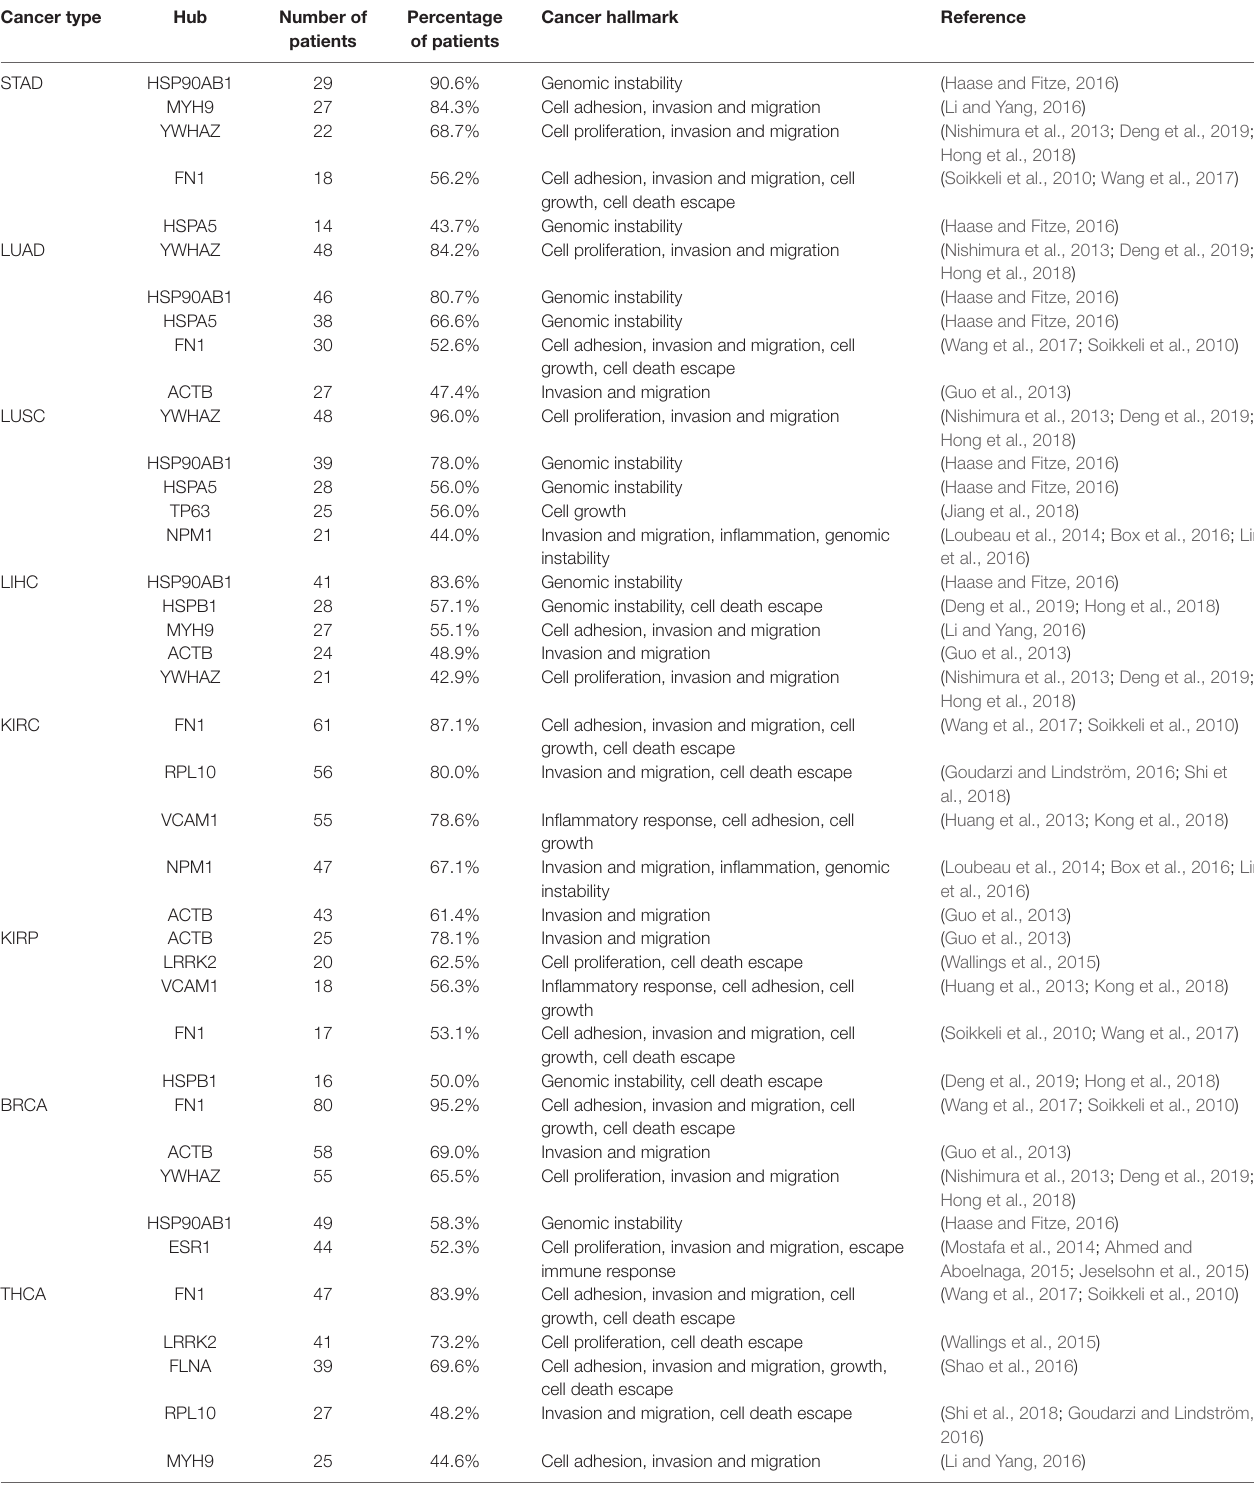
TABLE 2 | List of the five most frequent hubs, their incidence in patients for each cancer type, and their respective cancer hallmark. Cancer